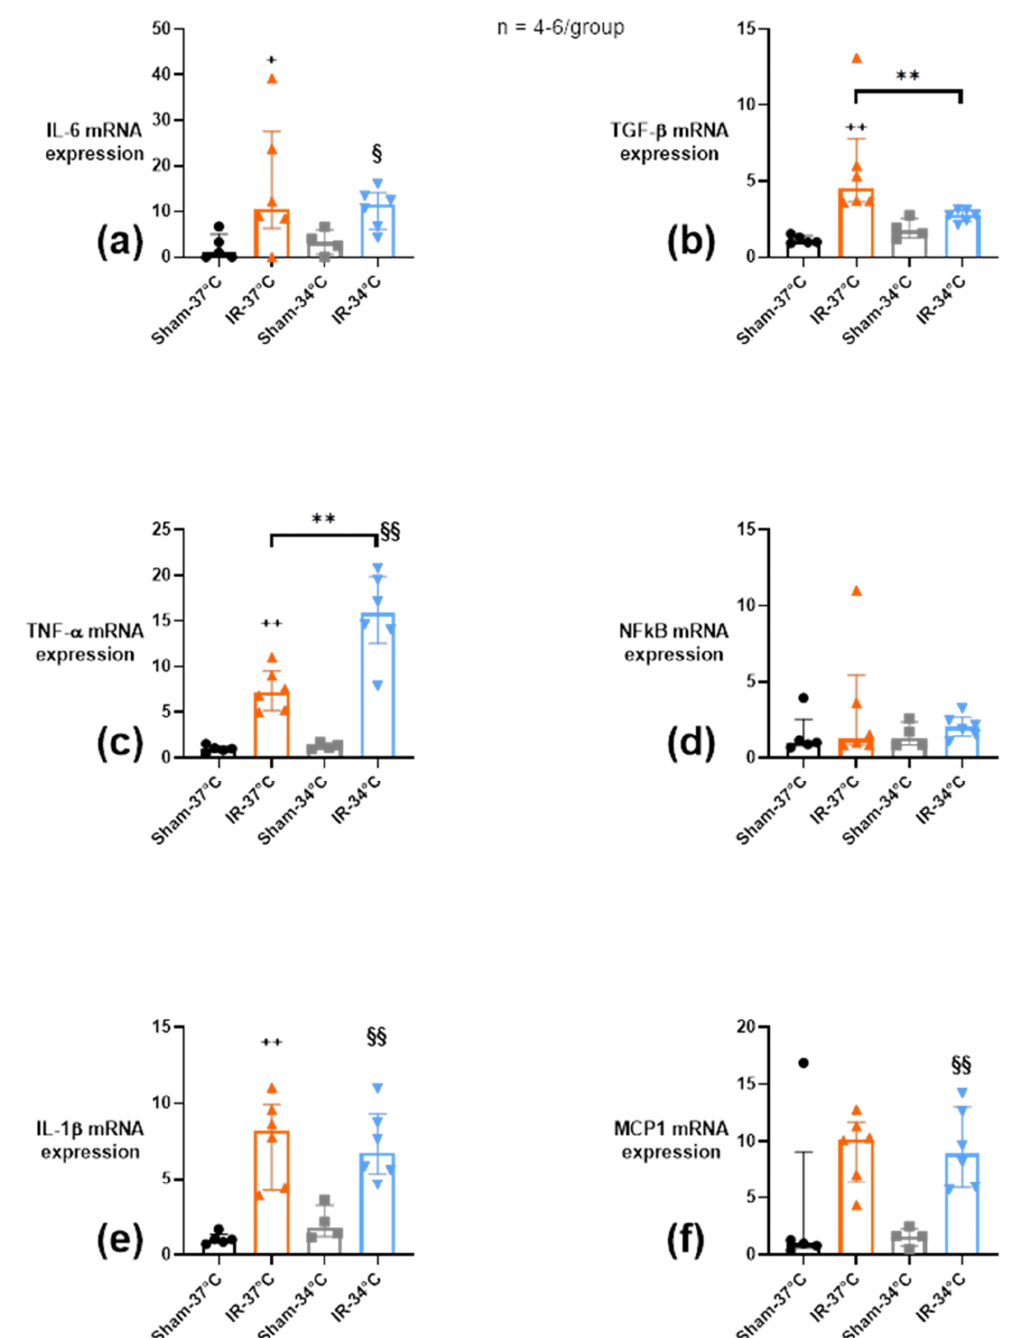
Figure 7. mRNA expression of inflammatory markers IL-6, TGF- β , TNF- α , NFkB, IL-1 β and MCP1 assessed by qPCR in ischemic kidney after 15 min of unilateral renal ischemia where the mice body temperature was maintained at normothermia (IR-37 ◦ C) or at mild therapeutic hypothermia (mTH) (IR-34 ◦ C), followed by 1 month of reperfusion, or after a Sham procedure with the same body temperature (Sham-37 ◦ C and Sham-34 ◦ C). ( a – f ) Renal ischemia-reperfusion induced an overexpression of IL-6, IL-1 β , TGF- β , TNF- α , and a trend toward MCP1 after 1 month of reperfusion. mTH applied during ischemia however attenuated the chronic overexpression of TGF- β , but increased it for TNF α . Actin mRNA was used as an internal standard to normalize the abundance of cDNA in each sample to normalize results. Data are shown as median with interquartiles. ** p < 0.01, Mann–Whitney test. + p < 0.05, ++ p < 0.01 vs. Sham-37 ◦ C, Mann–Whitney test. § p < 0.05, §§ p < 0.01 vs. Sham-34 ◦ C, Mann–Whitney